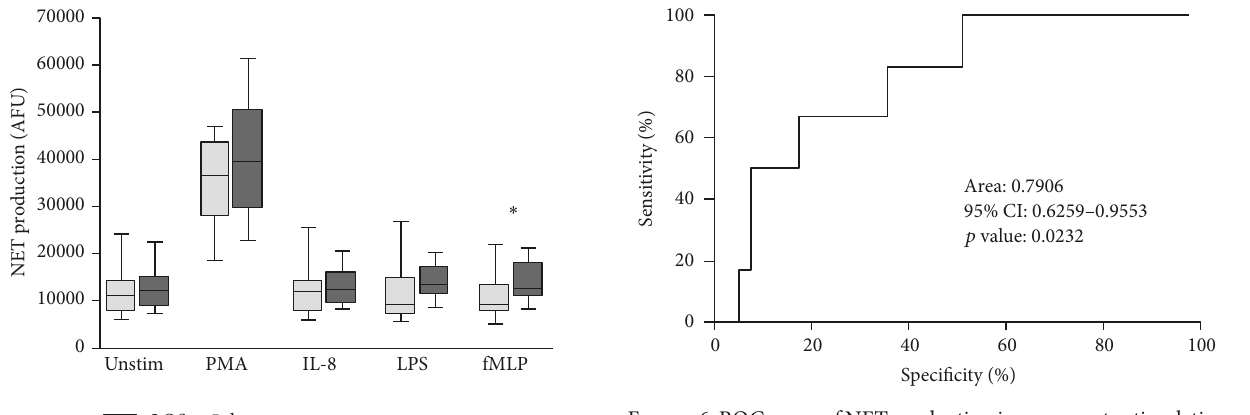
Figure 6: ROC curve of NET production in response to stimulation with fMLP for Clavien-Dindo classification < 3 ( 𝑛 = 38 ) versus Clavien-Dindo classification ≥ 3 ( 𝑛 = 6